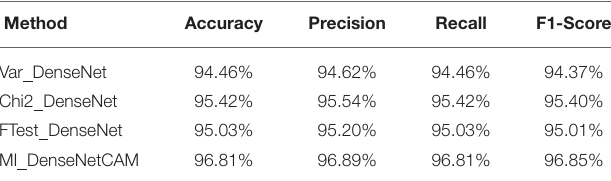
TABLE 4 | The performance evaluation results of different preprocess strategies.